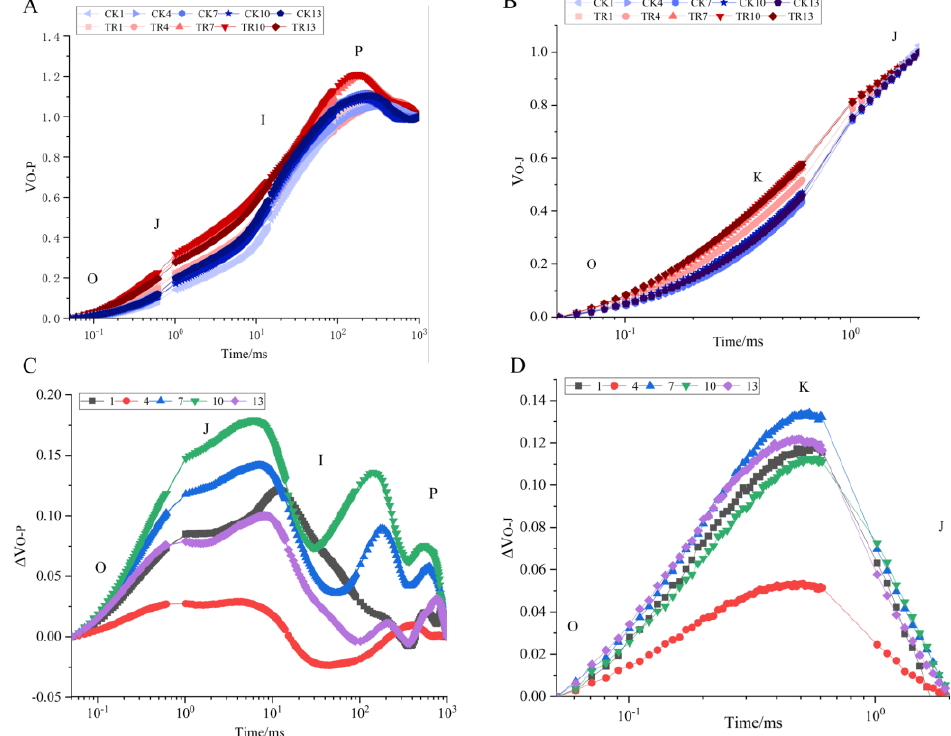
Figure 2. Analysis of O-P and O-J curves to standardize P. thunbergii needles under PWN stress. ( A ) Trends of O-P normalized fluorescence curves; ( B ) Trends of O-J normalized fluorescence curves. ( C ) Trends of O-P standardized difference fluorescence curves; ( D ) Trends of O-J standardized difference fluorescence curves. The numbers 1, 4, 7, 10, and 13 indicate days 1, 4, 7, 10, and 13 after inoculation.